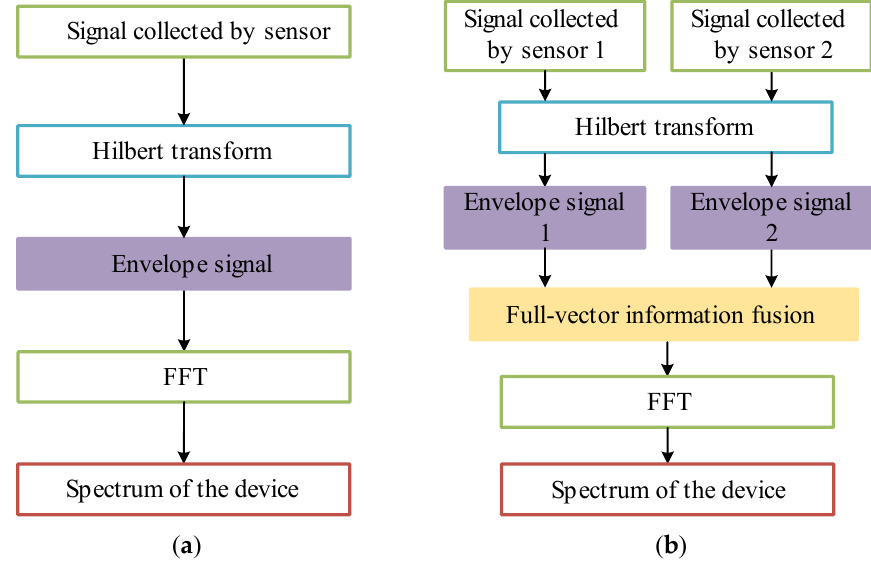
Figure 2. The processing flow of fault feature extraction: ( a ) The processing flow of the traditional Hilbert-envelope spectrum; ( b )The processing flow of the Hilbert–full-vector spectrum.